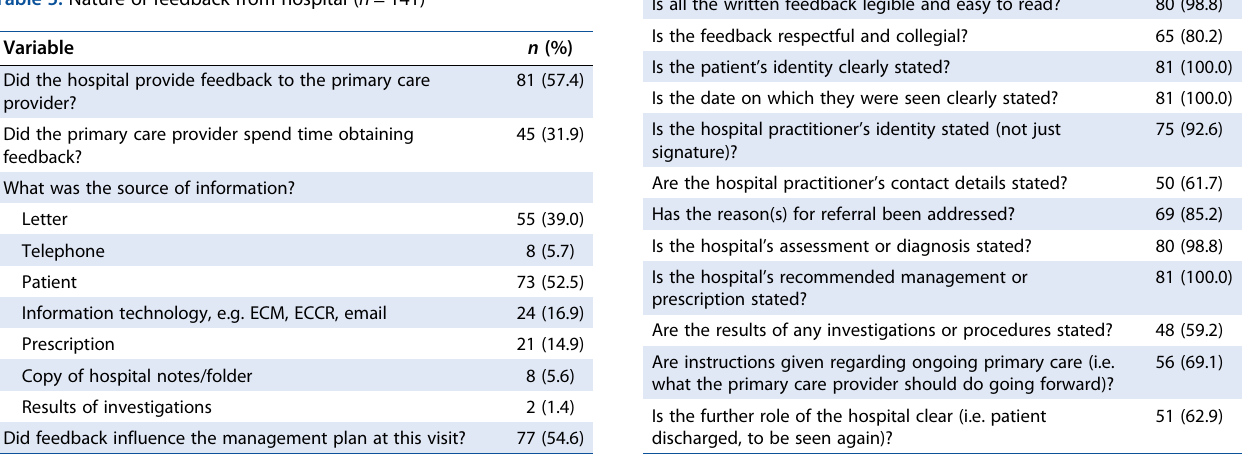
Table 6: Quality of written feedback from referral hospital ( n = 81)